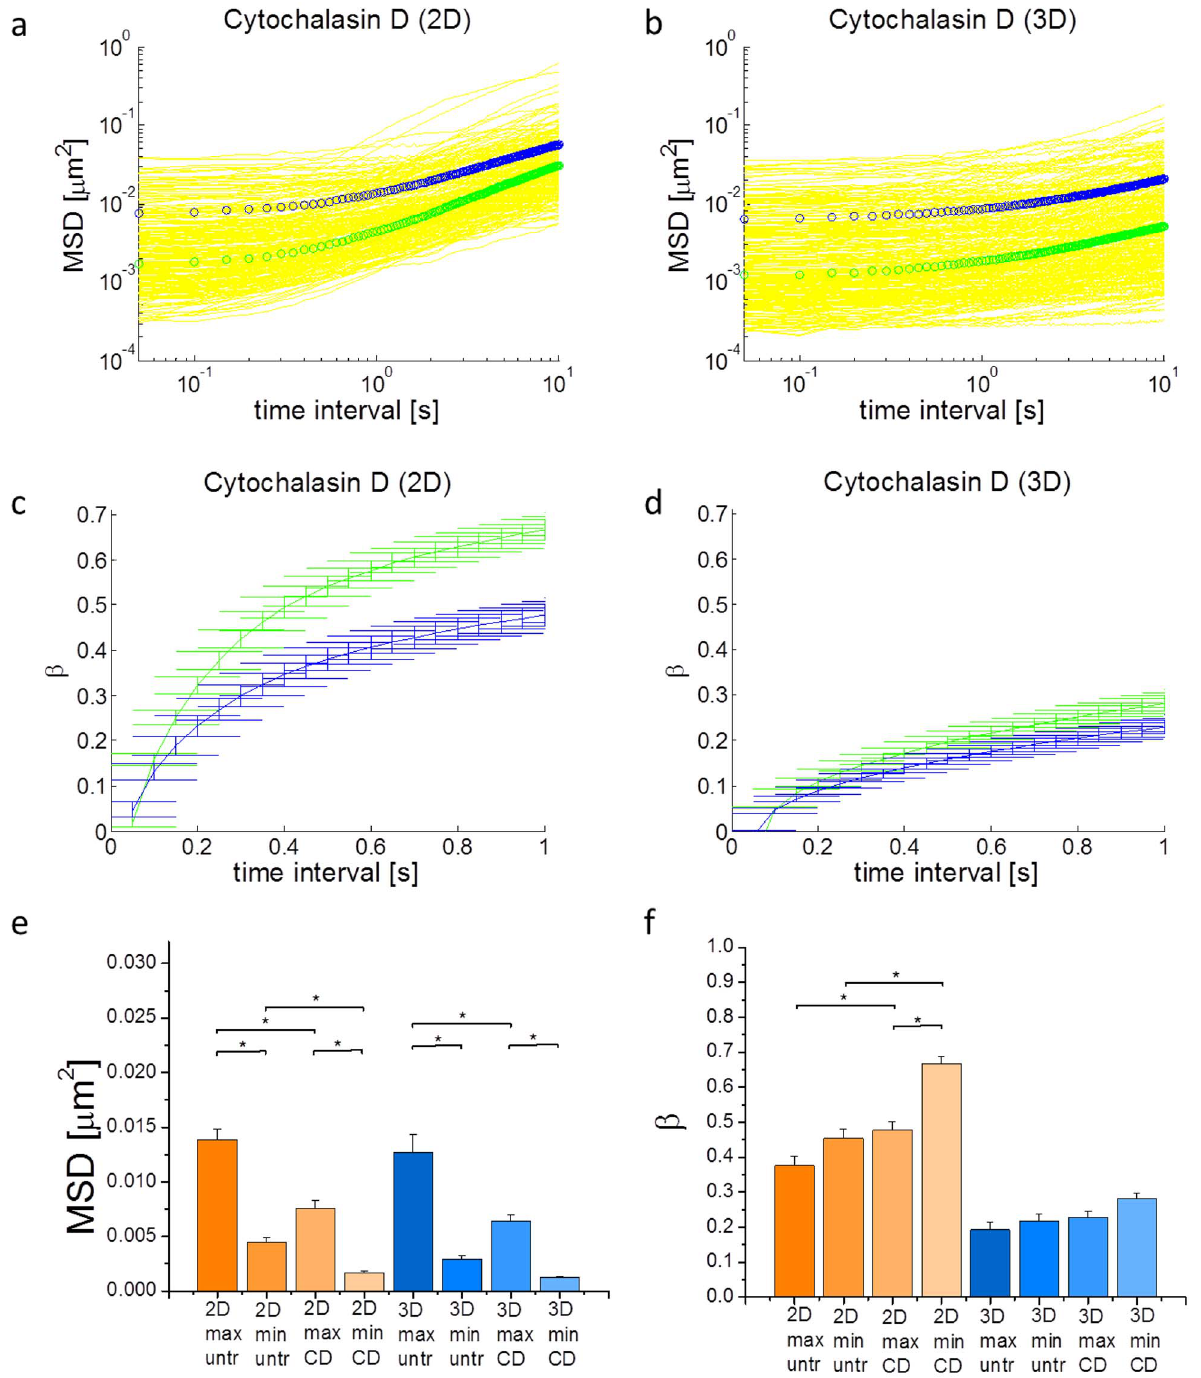
Figure 4. Cytochalasin D treated cells in 2D and 3D. a,b) MSDs of cells treated with Cytochalasin D in (a) 2D and (b) 3D. c,d) b ’s of cells treated with Cytochalasin D in (c) 2D and (d) 3D. e) Comparison of MSDs at 50 ms of untreated and Cytochalasin D treated cells in 2D and 3D. f) Comparison of b ’s at 1s of untreated and Cytochalasin D treated cells in 2D and 3D. Max and min indicate the 1D direction of maximum and minimum fluctuations, respectively. ‘‘untr’’ and ‘‘CD’’ indicate untreated and Cytochalasin D treated cells, respectively. Cells in 2D exhibit a more pronounced effect under treatment than cells in 3D. Error bars are s.e.m. * indicates p , 0.05. The color code in (a) and (b) is the same as in Figure 2b.